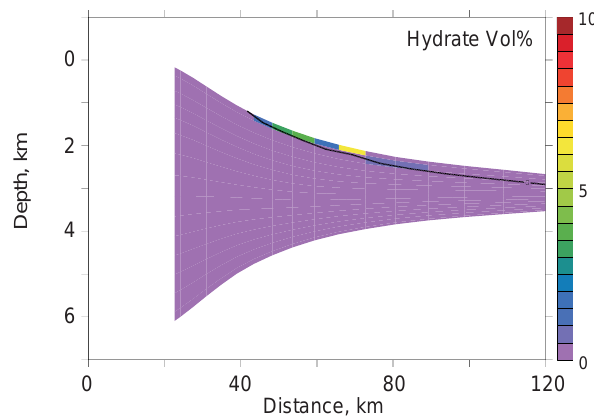
Fig. 11. Methane hydrate concentration, percent pore volume, for the Base scenario with various other scenarios in the Supplement file hydrate.pdf. Solid black line is the stability boundary. Plot- ted with various other scenarios in Fig. 11 (Supplement). Anima- tions can be seen at http://geosci.uchicago.edu/~archer/spongebob_